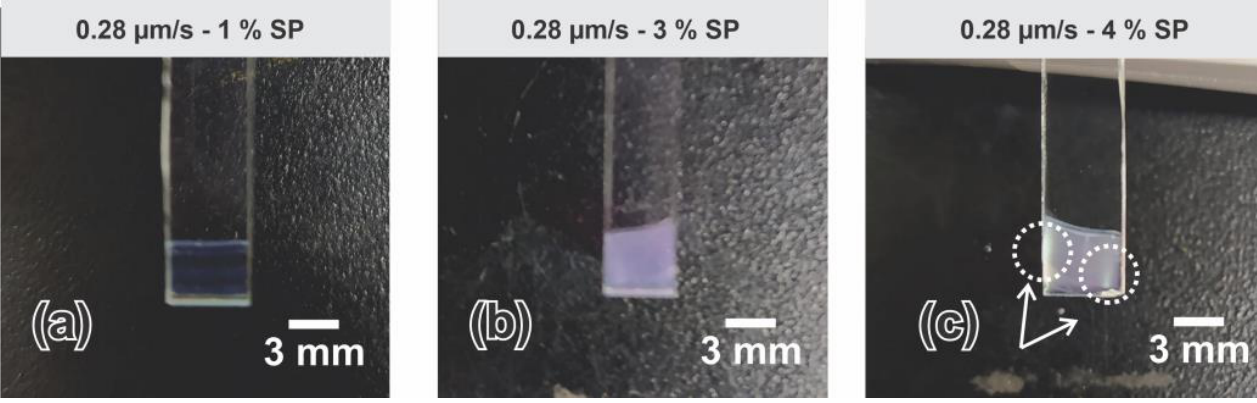
Figure 6. Images of C-PC fabricated at 0.28 µm/s and ( a ) 1%, ( b ) 3%, and ( c ) 4% SP concentration.